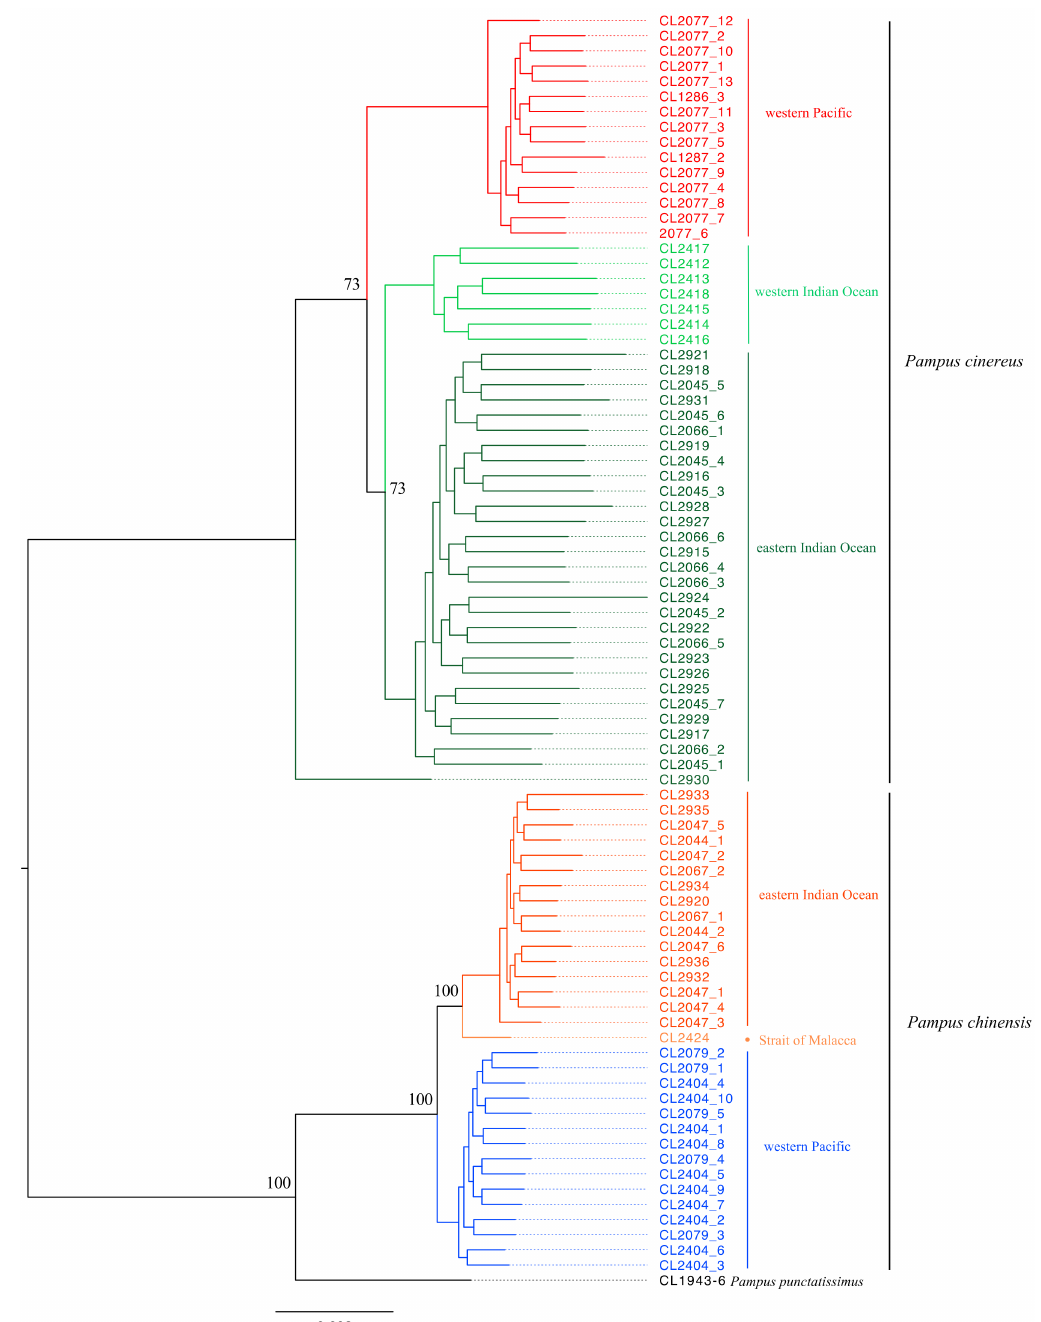
Figure 4. Concatenated phylogenetic tree of Pampus chinensis and P . cinereus . Each species is mainly diverged into two lineages that are respectively the Pacific and Indian Ocean lineages. Note that two outgroups Peprilus medius and Psenopsis anomala were omitted from this figure, but P. punctatissimus was retained as the outgroup of P. chinensis . Bootstrap values were beside the